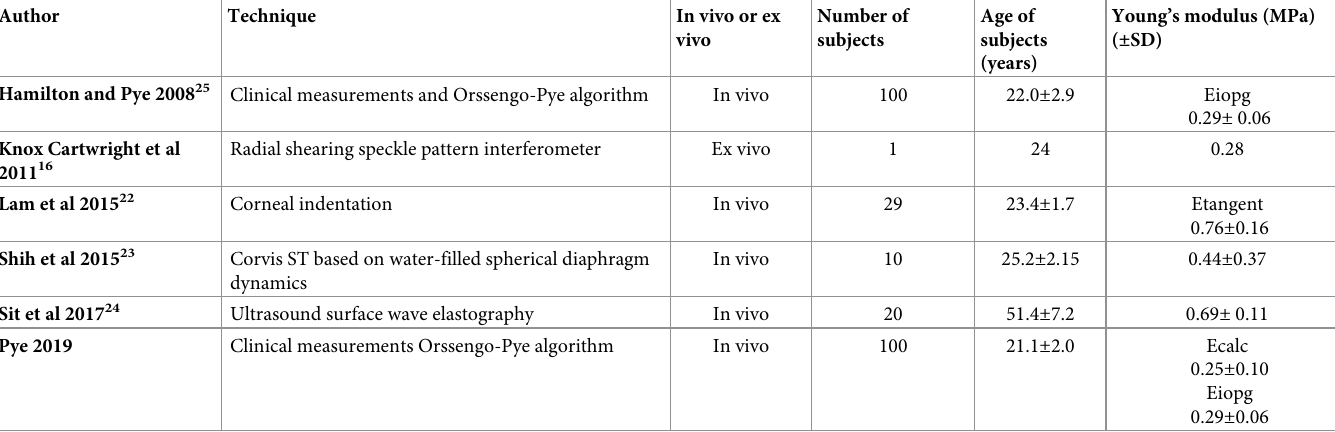
Table 3. Published values for the Young’s modulus for human corneas of human subjects of similar age to those in this study.